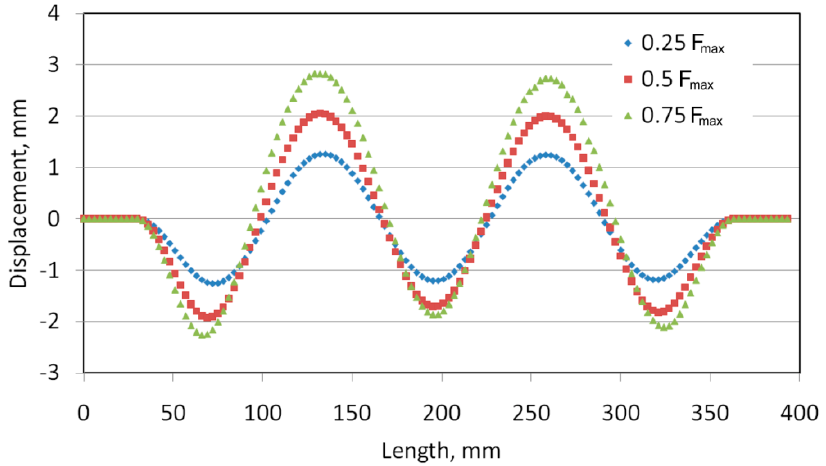
Figure 9. Path for measurement of out-of-plane deformation. Figure 9. Path for measurement of out ‐ of ‐ plane deformation. Figure 9. Path for measurement of out ‐ of ‐ plane deformation. Figure 9. Path for measurement of out ‐ of ‐ plane deformation.